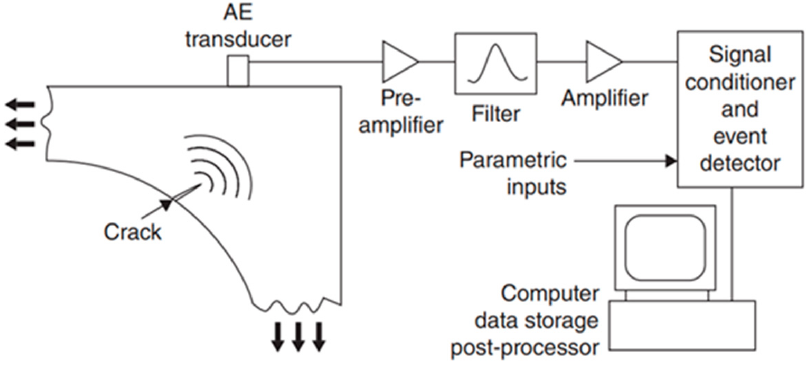
Figure 7. Graphical illustration of a conventional AE measurement system [76].